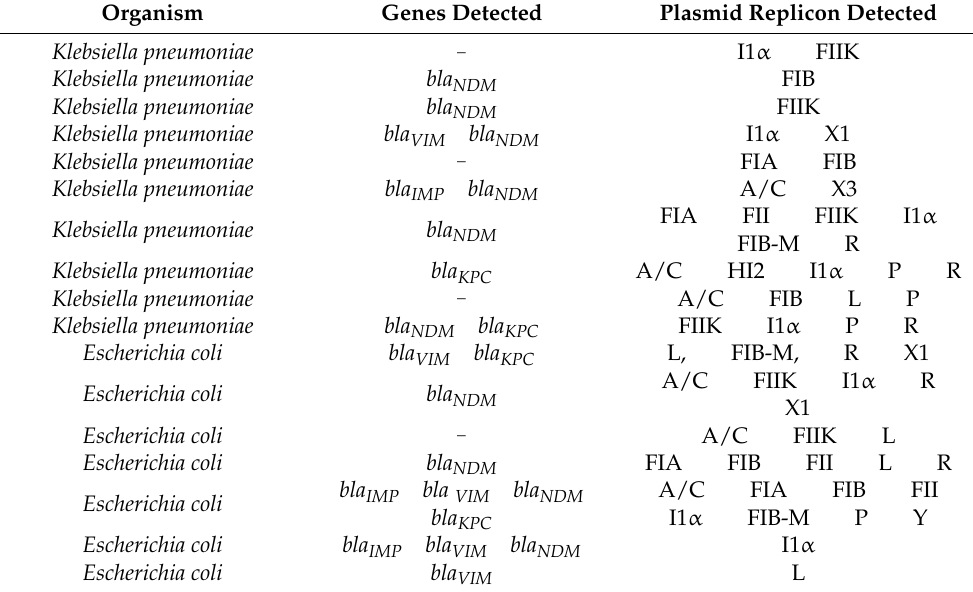
Table 6. Patterns of carbapenemase-encoding genes and plasmid replicons detected in studied isolates.